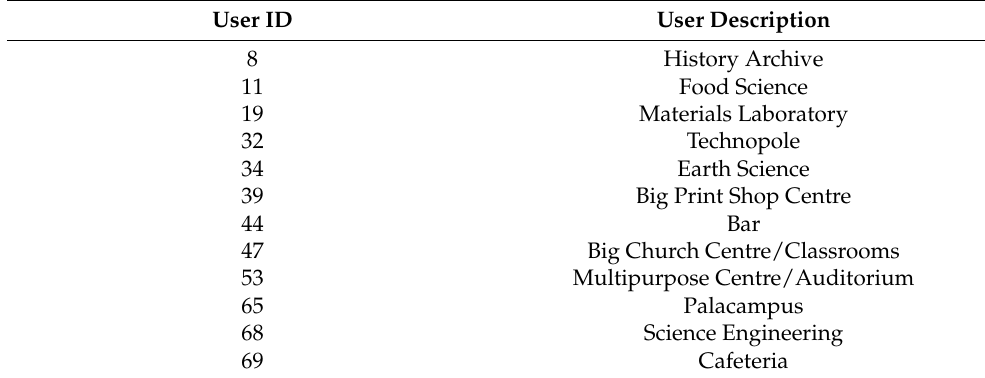
Table A1. Buildings supplied by the “Nuova Sud” network.